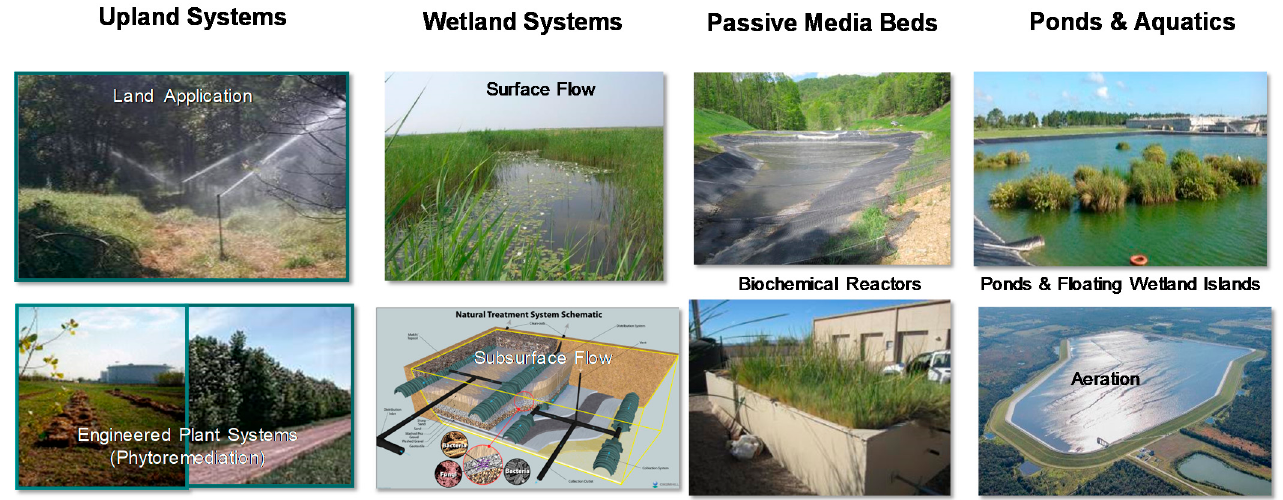
Figure 1. Various CW treatment options under the toolbox approach.